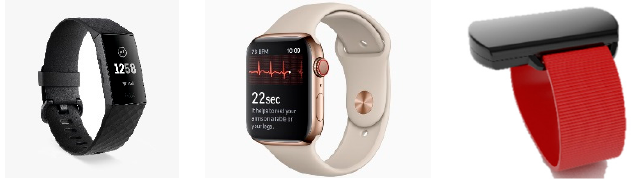
Figure 2. Fitbit health and fitness tracker (left), Apple watch (middle), SPHERE activity sensor (right) [24].